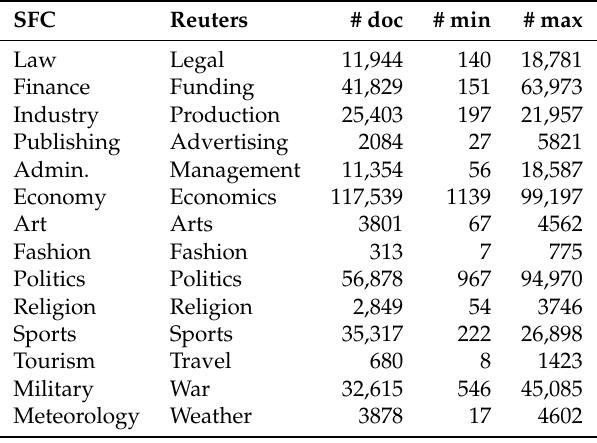
Table 1. The Reuters and Subject Field Codes (SFC) category